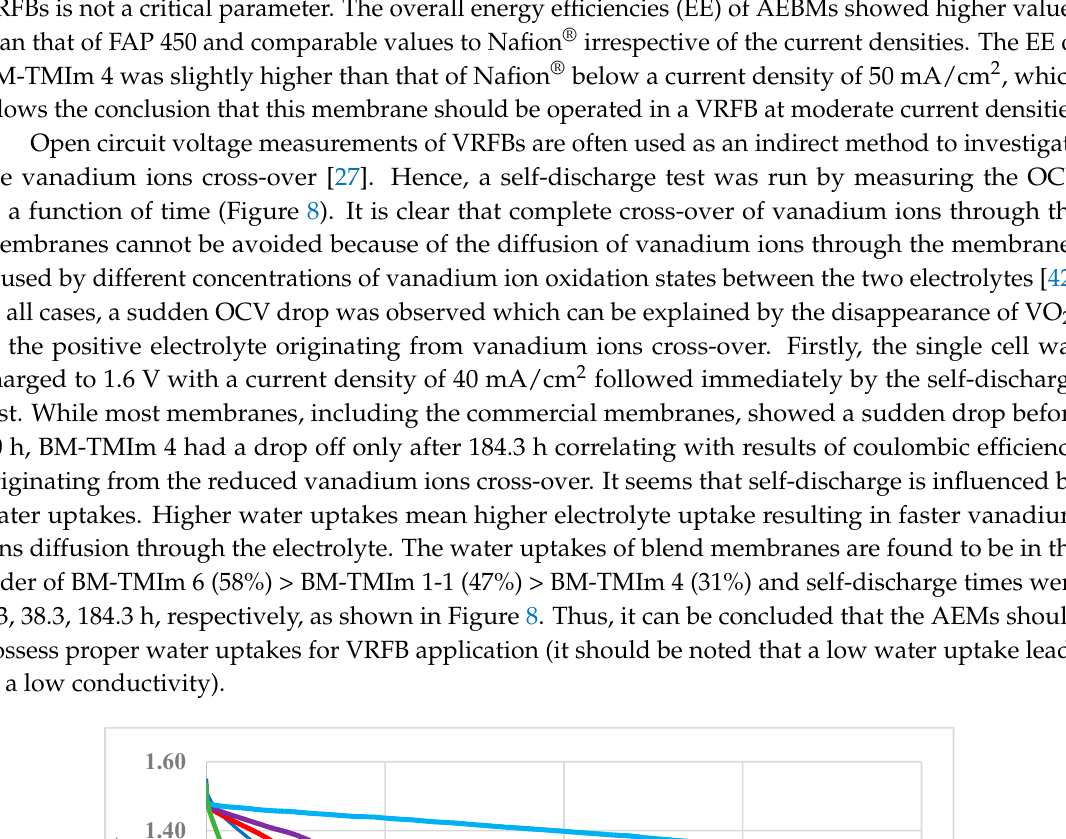
Figure 9. Charging – discharging cycles tests of blend membranes BM-TMIm 1-1 and BM-TMIm 6. Because BM-TMIm 4 possessed the longest self-discharge time of all the tested membranes in this study, a long-term charging–discharging cycles test was conducted with this blend membrane (Figure 10). It turned out that the coulombic efficiency remained almost 100% (99.6–99.5%) over 300 cycles. According to Figures 9 and 10, the BM-TMIm 4 membrane showed less capacity decay than BM-TMIm 1-1. This result suggests that by adjusting anion-exchange polymer proportion in the blend membrane, improved performance in VRFBs can be achieved. According to Figure 10, the capacity retention of BM-TMIm 4 measured at a current density of 40 mA/cm 2 was 95%, 86%, and 77% at the 100th, 200th, and 300th cycle, respectively. Compared with values from other VRFB